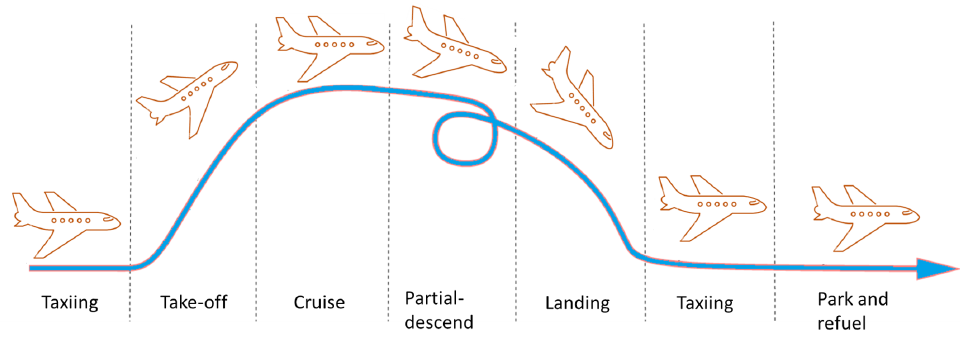
Figure 2. Typical flight profile of an aircraft